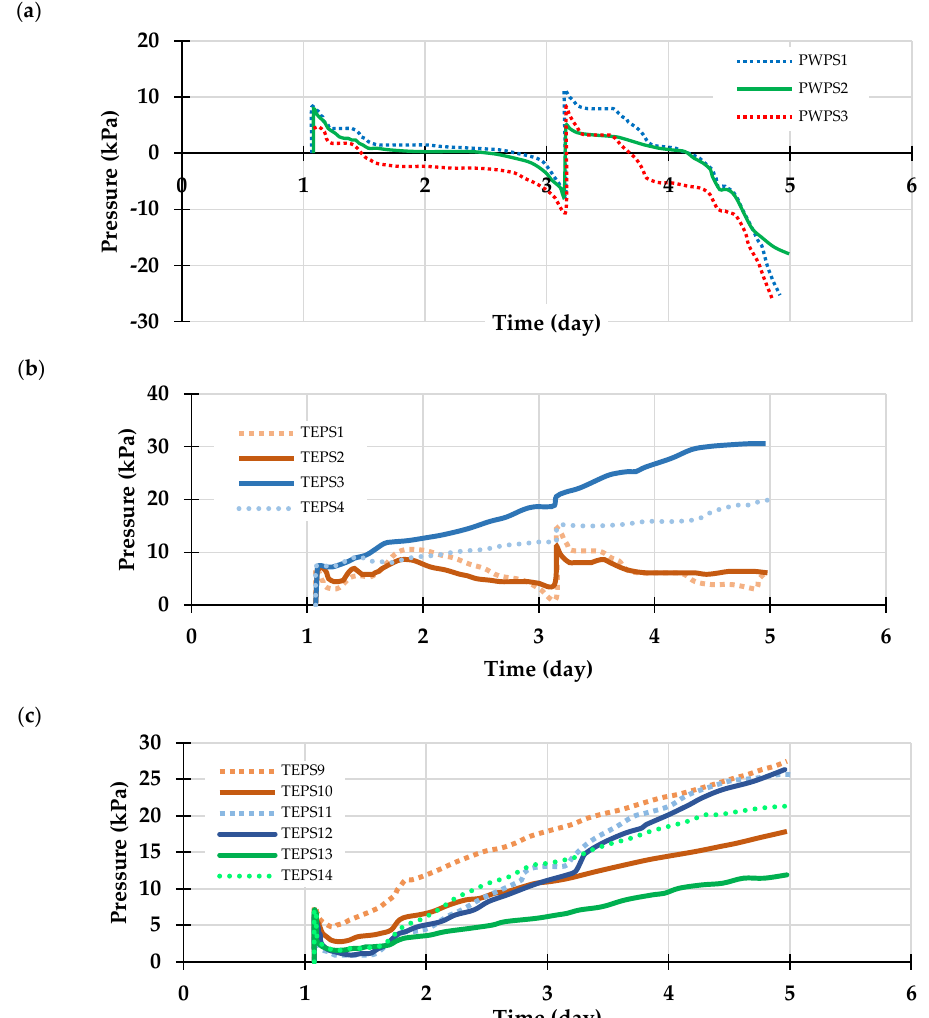
Figure 14. Total pressure measurements: ( a ) The pore water pressure at the base of stope (PWPS 1), in front of the barricade (PWPS 2), and at 20 cm above the stope (PWPS 3). ( b ) The total pressure at the base of the stope. ( c ) The backfill pressure measurement on the upstream side of the